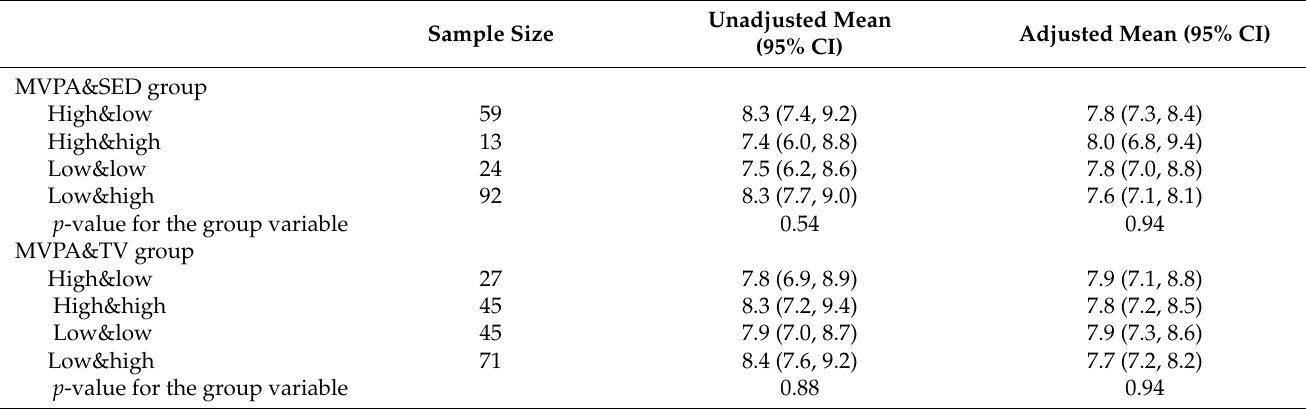
Table 4. Unadjusted and adjusted means of fat mass index among MVPA&SED and MVPA&TV groups among